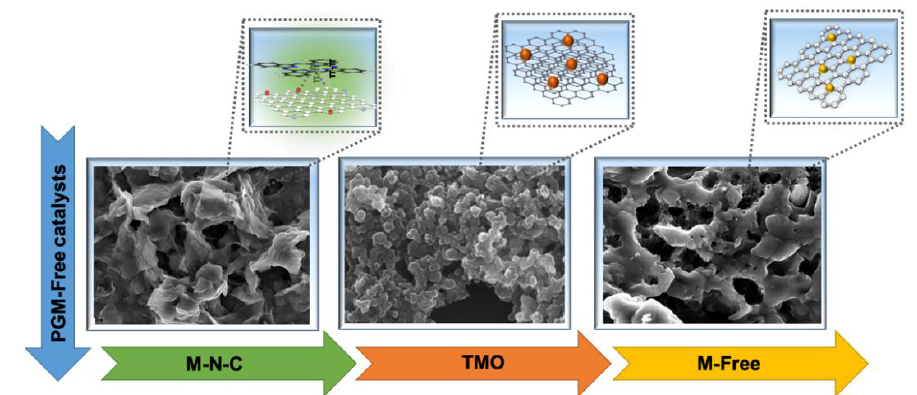
Figure 3. Schematic illustration of M-N-C catalysts, transition metal oxide (TMO) catalysts, and activated carbon catalysts, with typical scanning electron microscopy (SEM) images. PGM, platinum group metal.